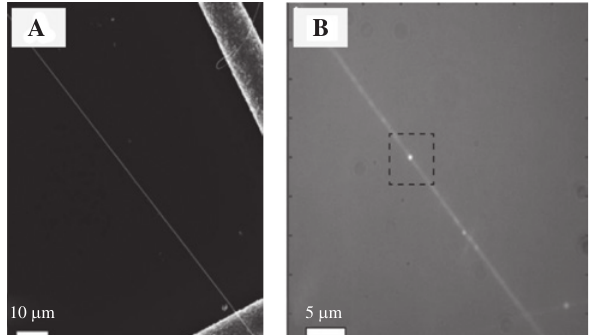
Figure 8: (A) Single, free-standing ONF viewed under SEM on a TEM grid. (B) Wide-field fluorescence image of an isolated quantum dot (in the dashed box) from a fiber similar to that seen in (A). (Reprinted with from Gaio et al. ACS Nano, 10, 6125,